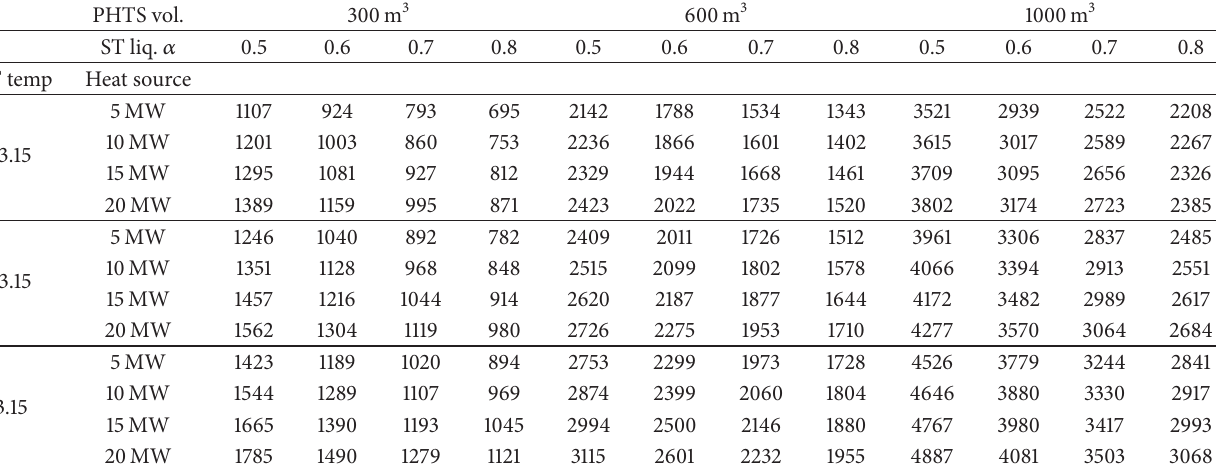
Table 2: Minimum ST volume in m 3 .